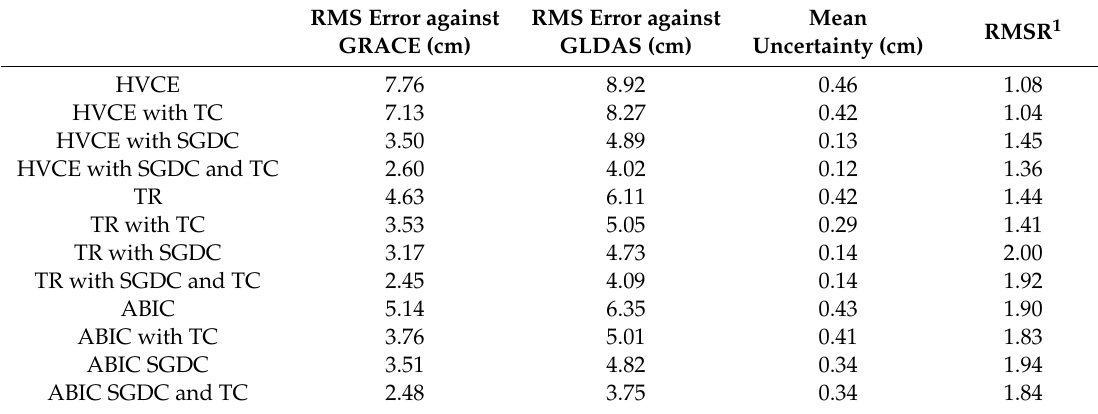
Table 1. Statistics of the GPS-inferred TWS from various constraints (i.e., the spatial GRACE data constraints (SGDC) and terrain-corrected GPS (TC)) and inversion approaches. RMSR 1 is the variance component of the observations.